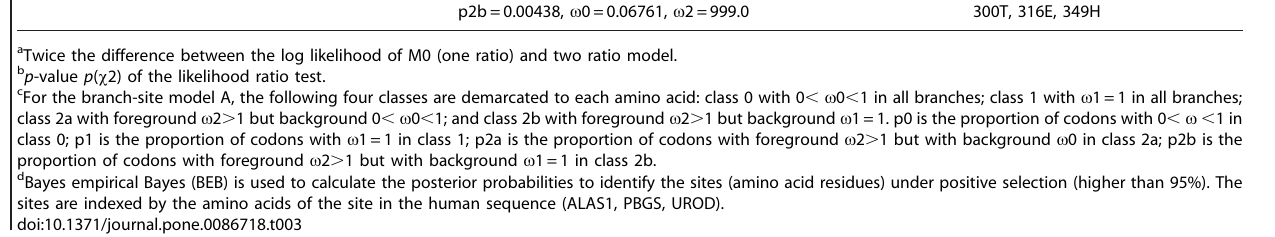
Foreground branches